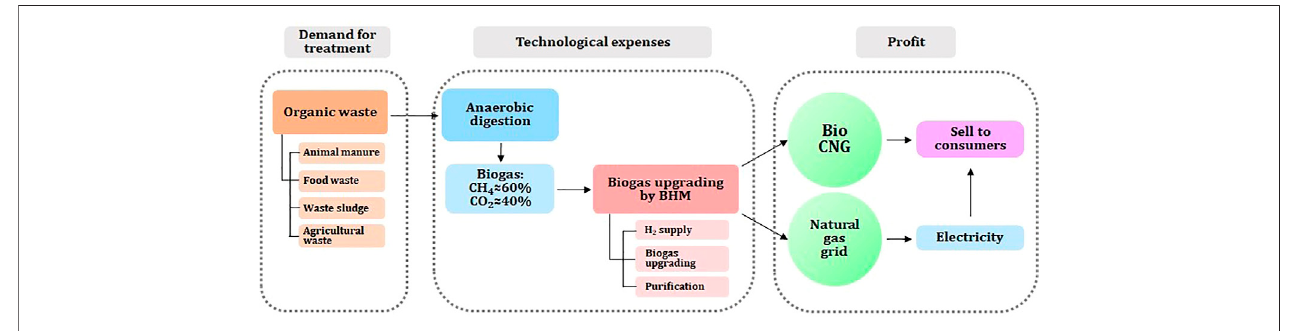
FIGURE 3 | Business model for biogas